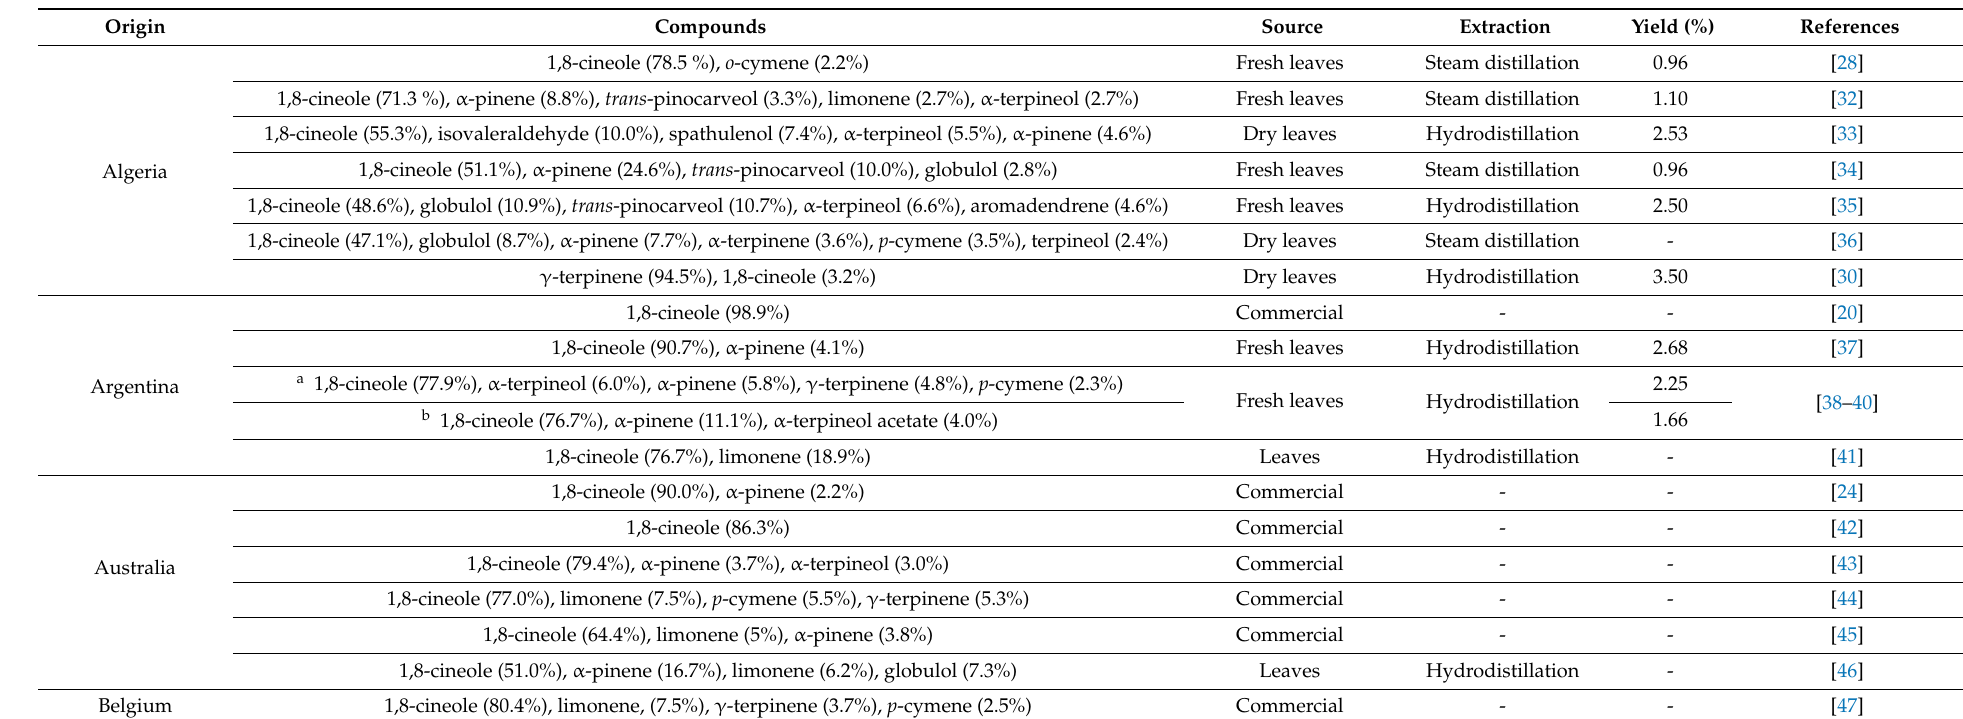
Table 1. Chemical components present at ≥ 2%, of the essential oils from Eucalyptus globulus